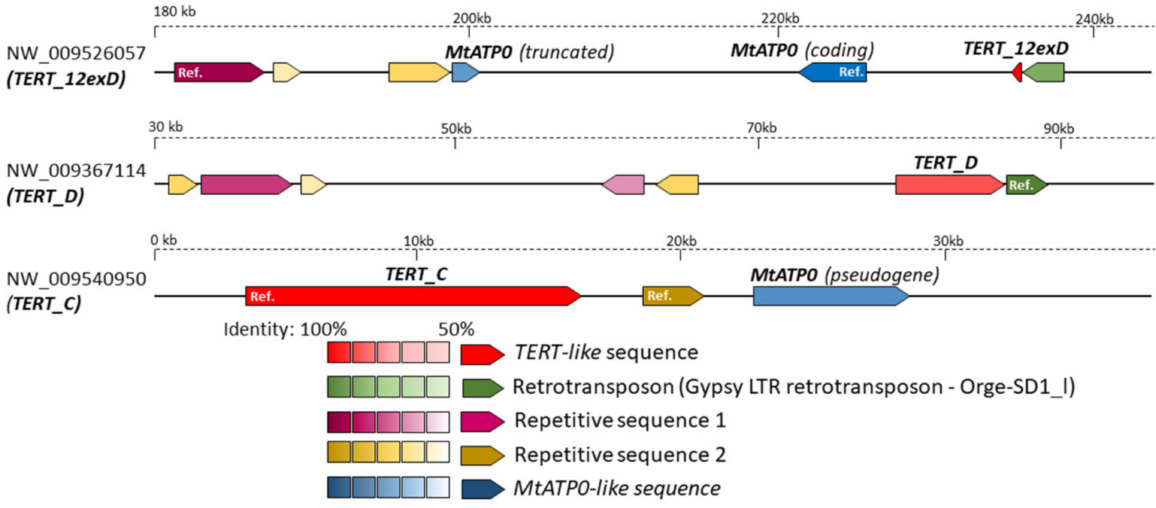
Figure 4. Arrangement of TERT -like sequences identified in the N. sylvestris genome assembly. Ancient TERT gene duplication is documented in contigs identified by BLAST search. The TERT _C variant represents a functional TERT copy. Two more contigs contained TERT -like sequences ( TERT _D, TERT _12exD) that probably originated from TERT duplication and translocation because the TERT _12exD sequence stands for the 92 nt long region homologous to the end of exon 12 that is missing in the TERT _D variant. Mutual comparison of three TERT contigs in GEvo revealed the presence of the delta subunit of mitochondrial ATP synthase ( MtATP0 ) that is often associated with TERT . Moreover, two repetitive sequences and retrotransposon Ogre-SD1_I that may be responsible for the split of TERT _D and TERT _12D sequences were identified. Sequence similarities (in %) are illustrated by a color scale relative to the reference sequence (Ref., 100%), as indicated. Table 3. Number of TERT copies in N. sylvestris accessions determined by